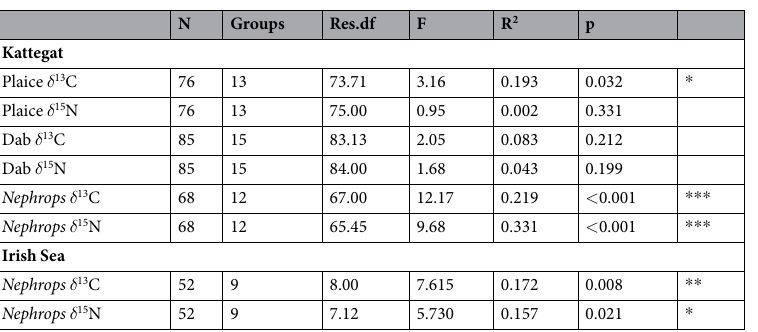
Table 2. GAMM statistical outputs presented in Fig. 3 A-H. Relationship of the response variables listed with trawling frequency y − 1 . Res.df are the residual degrees of